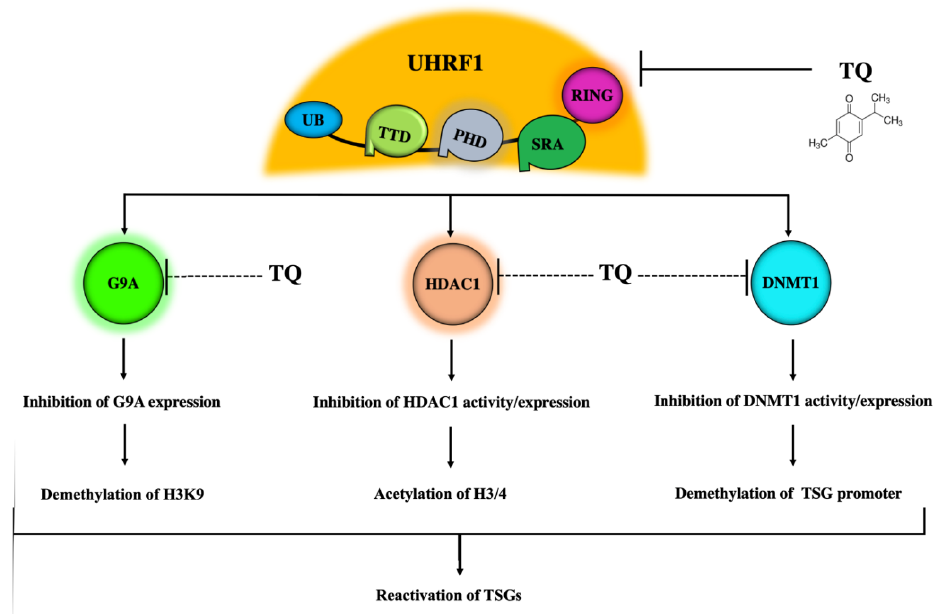
Figure 4. Schematic representation of TQ as a multitargeting single epidrug. TQ can directly inhibit the expression of UHRF1 protein leading to the inhibition of activity and/or activity of its partners DNMT1, HDAC1 and G9A. TQ could also target DNMT1, HDAC1 and G9A in UHRF1-indpendent mechanisms. DNMT1 inhibition leads to demethylation of TSG promoter. HDAC1 inhibition enhances the acetylation of histones 3 and 4. G9A inhibition causes demethylation of H3K9. All these TQ-induced effects lead to the reactivation of TSGs.